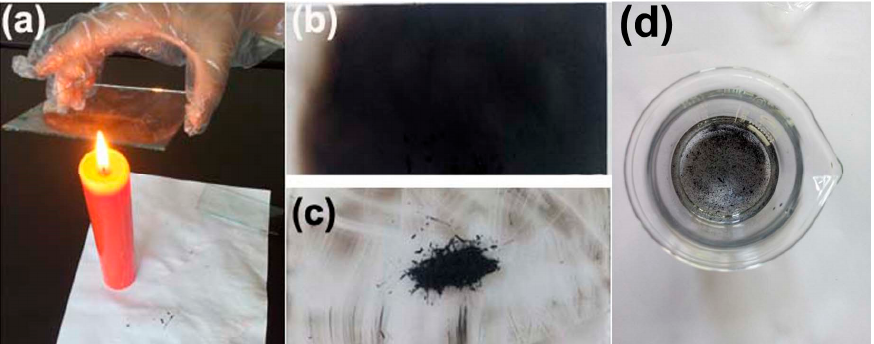
Figure 1. Preparation of CS solution: ( a ) a glass slide is held in the flame of a candle for 2 min; ( b ) a CS layer is deposited; ( c ) gather approximately 200 mg CS from glass slide; and ( d ) CS mixed